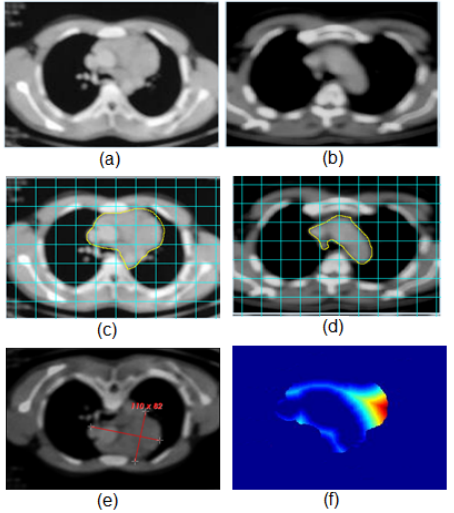
Figure 3. Novel approach to volume calculation using the local dissimilarity volume. Two MRI medical images: ( a – d ) MRI Images after segmentation; ( e ) Classical approach for volume calculation; ( f ) Local dissimilarity map between ( c , d